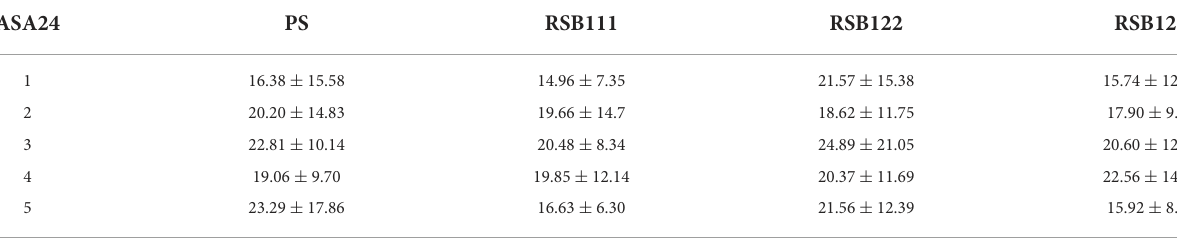
TABLE 3 Fiber intake per day, in grams, from self-reported ASA24 results, ITT analysis. ASA24